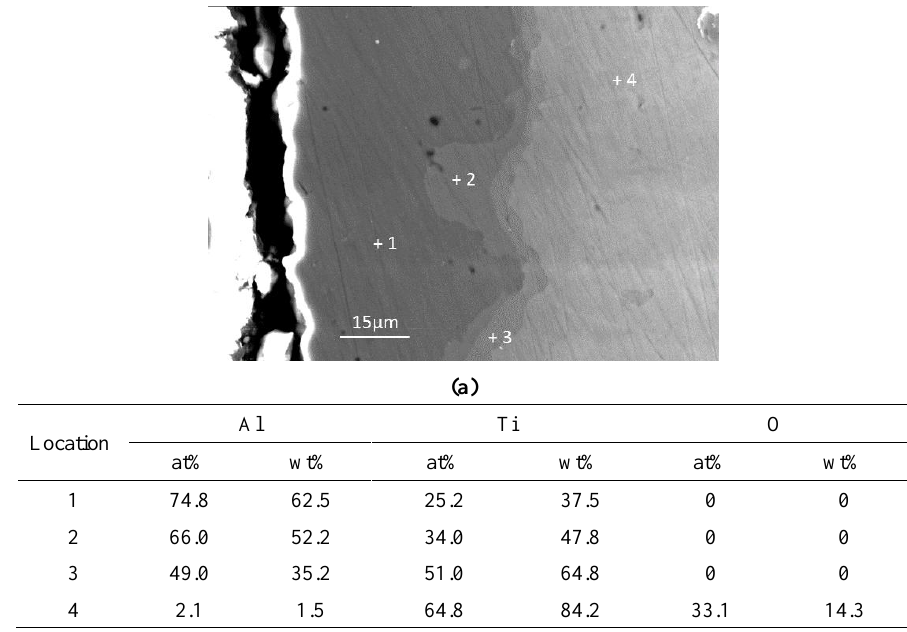
Figure 11. SEM image ( a ) and point quantitative elemental measurements ( b ) for cross-sectioned Ti aluminised at 1000 °C for 10 h.